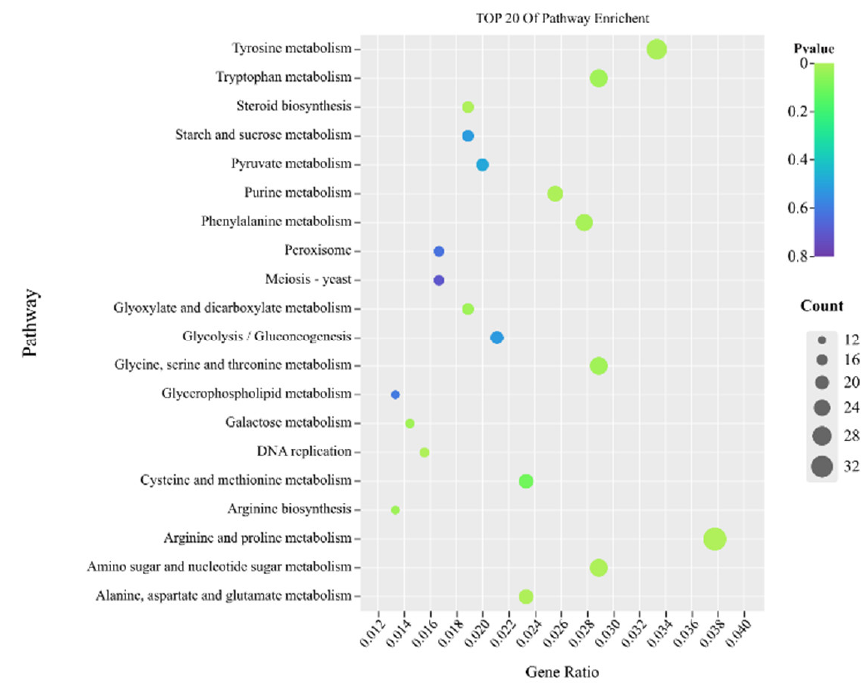
Figure 6. Bubble plot of the enriched KEGG pathways for DEGs. “Count” indicates the number of DEGs enriched in the pathway. “GeneRatio” indicates the ratio of enriched DEGs to background genes. The x-axis presents the percentage of DEGs belonging to the corresponding pathway. The y-axis represents the top 20